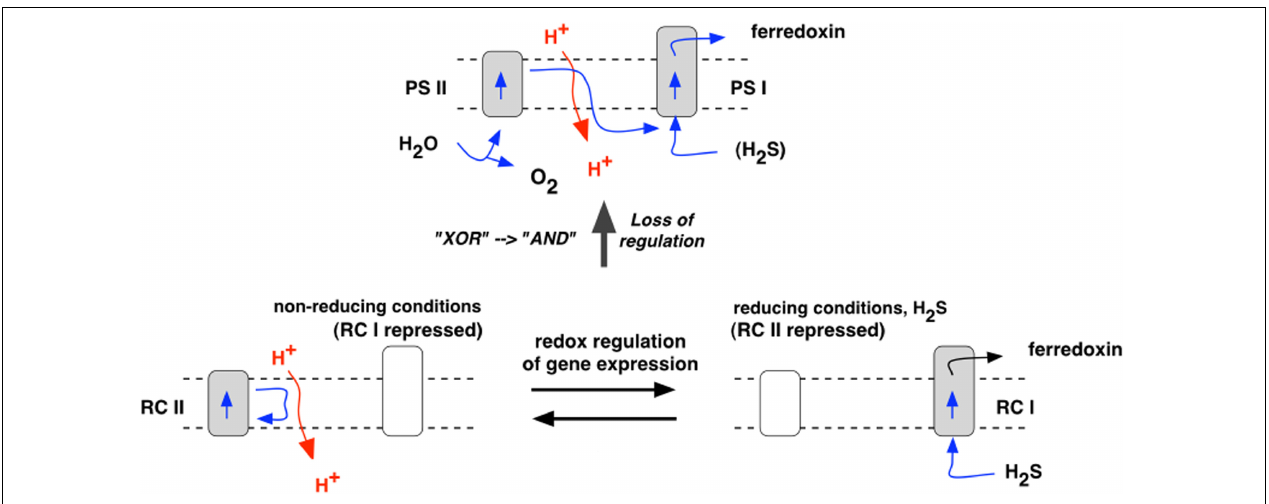
FIGURE 4 | The hypothetical protocyanobacterium. Expression of Type I center genes in the presence of H 2 S gives a Type I reaction center (RC I) and is accompanied by repression of Type II genes. In the absence of H 2 S, Type II genes are induced, giving a Type II reaction center (RC II), and Type I genes become repressed. Subsequent impairment of redox regulatory control allows expression and co-existence of both Type I and Type II reaction centers, with complementary functions. In place of H 2 S, the Type II center, as PS II, oxidizes water, liberating oxygen, and donates electrons to the Type I center, as PS I. The proposed loss of the redox regulatory switch replaces the logical (Boolean) relation “Type I XOR Type II” (each type excluding the other) with “Type I OR Type II” (either is, and both are, allowed). This in turn leads to “Type I AND Type II” when interdependency of PSs I and II is established in the non-cyclic electron transport chain of oxygenic